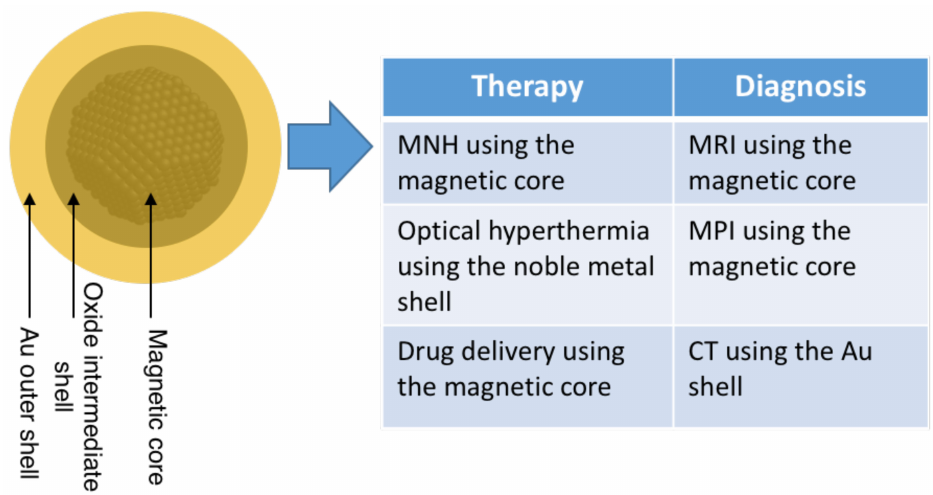
Figure 19. Core–shell–shell nanoparticle able to provide several therapeutic and diagnostic